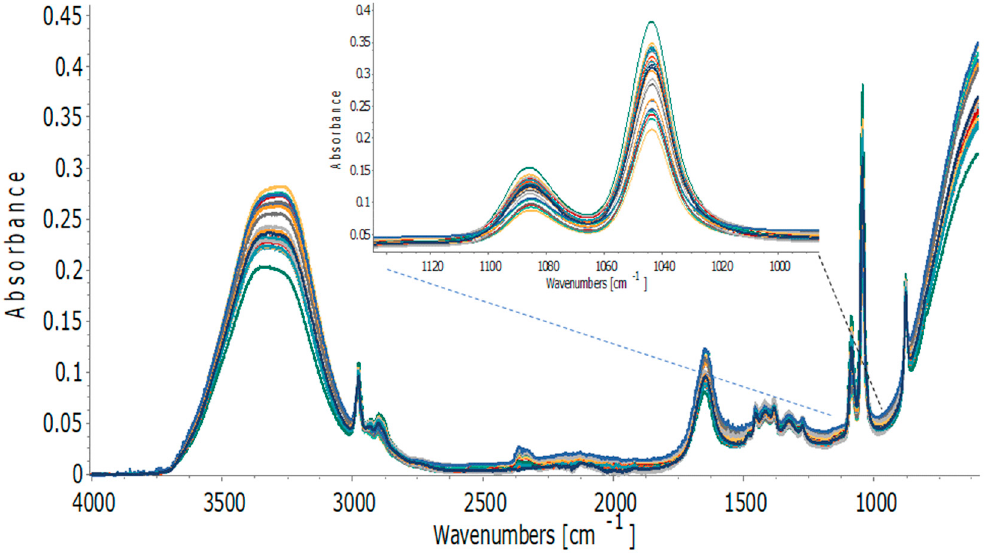
Figure 9. FTIR-ATR spectra obtained on 27 authenticated baijiu samples. Expansion insert shows the C-O stretch absorbances that are highly correlated to ethanol content showing the variance in these absorbances in the observed 38–66 %ABV range of the samples analyzed.